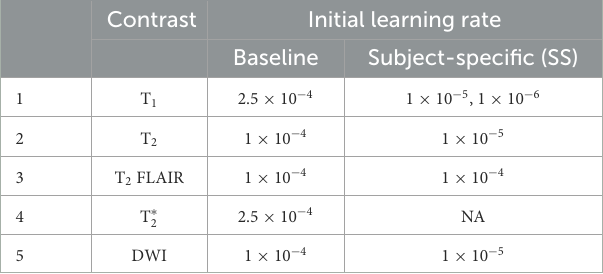
TABLE 2 Initial learning rates (LRs) for the contrast-specific baseline and subject-specific (SS) denoising